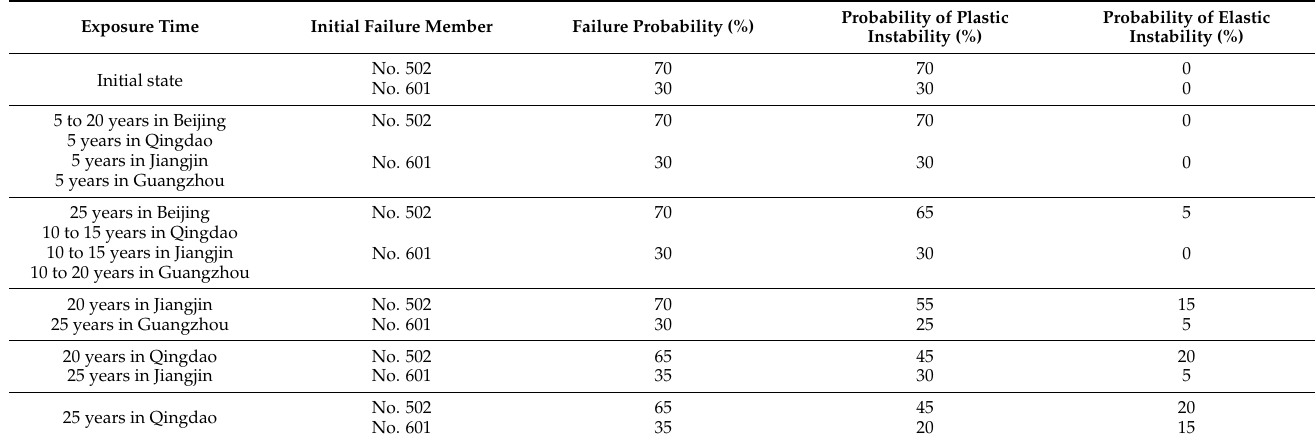
Table 11. Collapse failure probability of the transmission tower in each